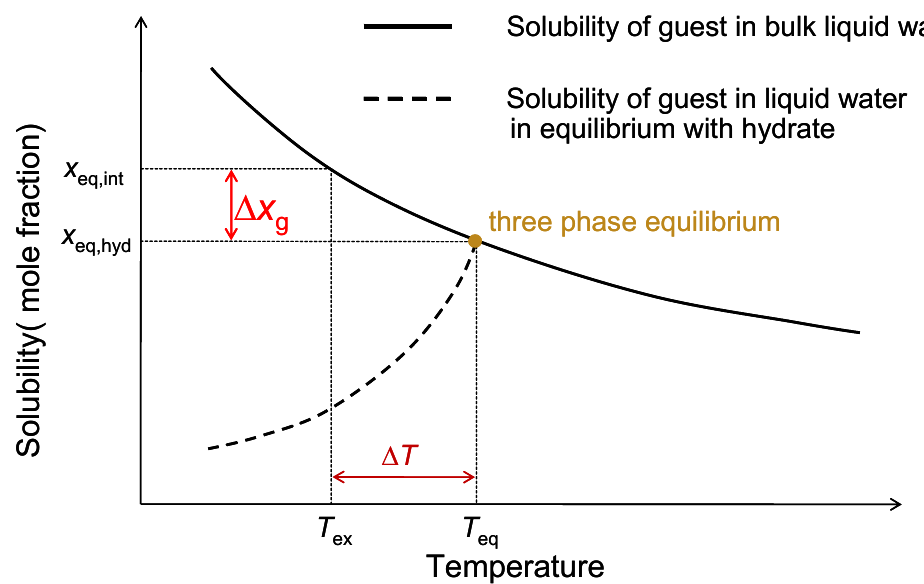
Figure 3. Schematic of solubility curves of guest species in